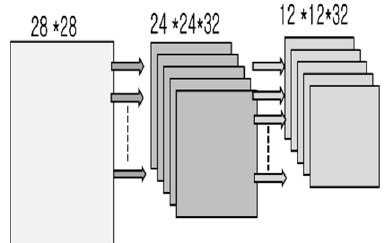
Figure 8. Diagram of the multilayer network structure.